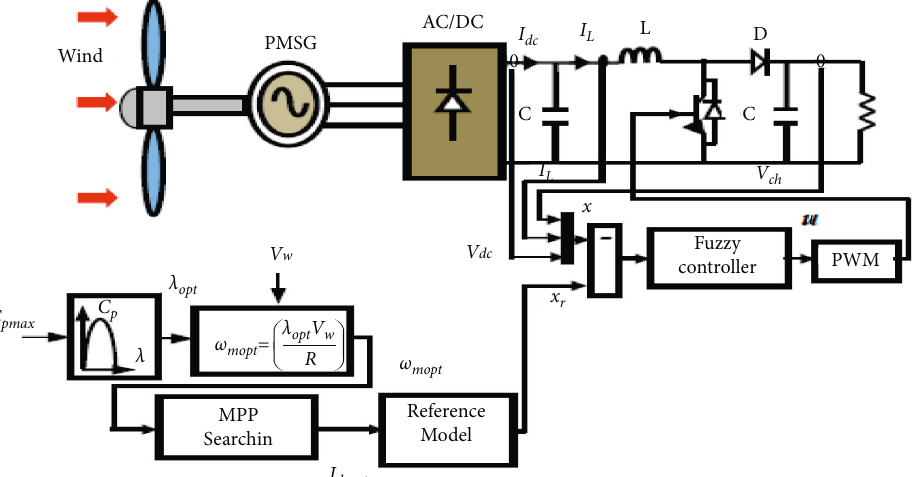
Figure 3: Fuzzy control strategy for